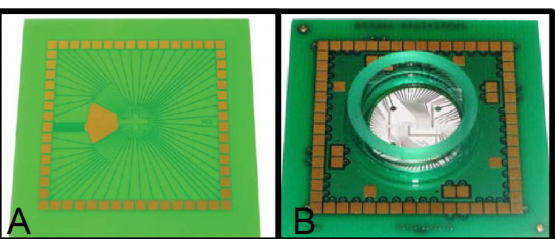
Figure 17. ( A ) Commercial PCB-based microelectrodes arrays of Multichannel Microsystems (model: 60EcoMEA). ( B ) Commercial PCB-based microelectrodes arrays of Ayanda Biosystems™ (model: MEA60 4 × 15